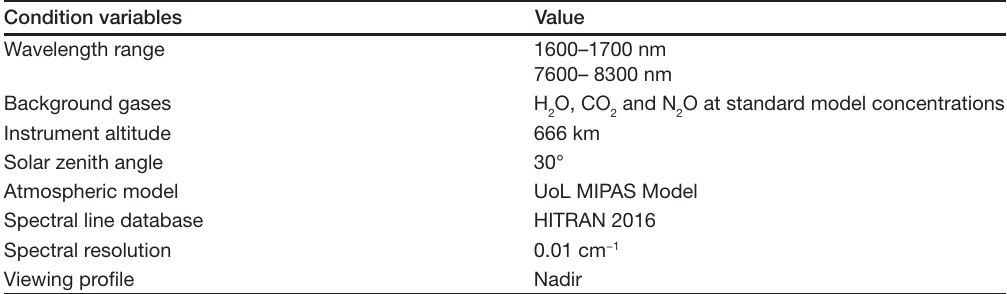
Table 1. The conditions used by ORFM in generating SWiR Absorption from an assumed GOSAT-TAN- SO-FTS-like instrument. All conditions are taken from MiPAS Model atmospheres [51].